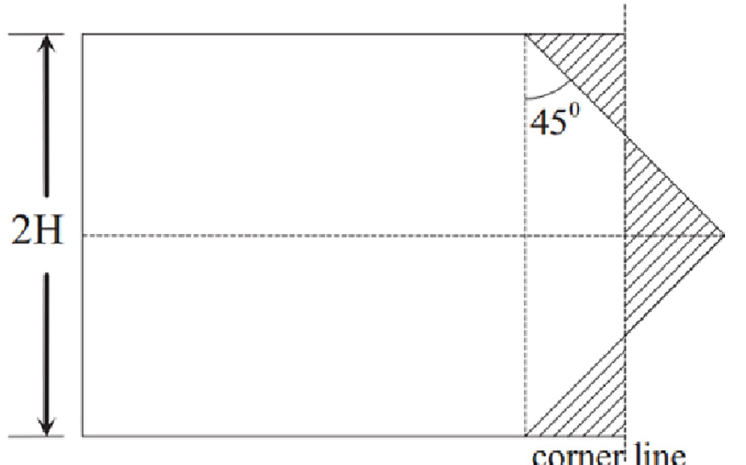
Fig 4. Basic folding element of the asymmetric mode.